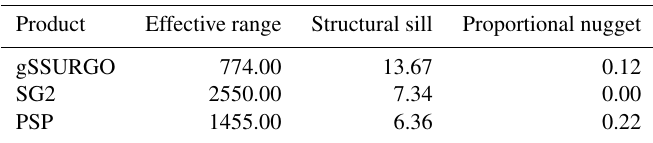
Figure 14. Fitted variograms for pH at 0–5cm. Semivariance units are (pH × 10) 2 . Note the shorter range of gNATSGO and the low sill of PSP. Table 7. Fitted variogram parameters for pH at 0–5cm. The effective range is in metres, the structural sill is in (pH × 10) 2 , and the proportional nugget is [ 0 ... 1 ]